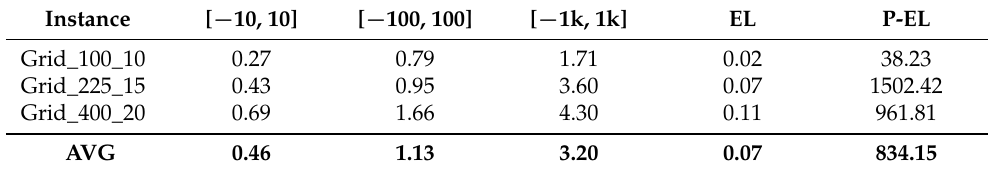
Table 1. Running times for the grid instances.